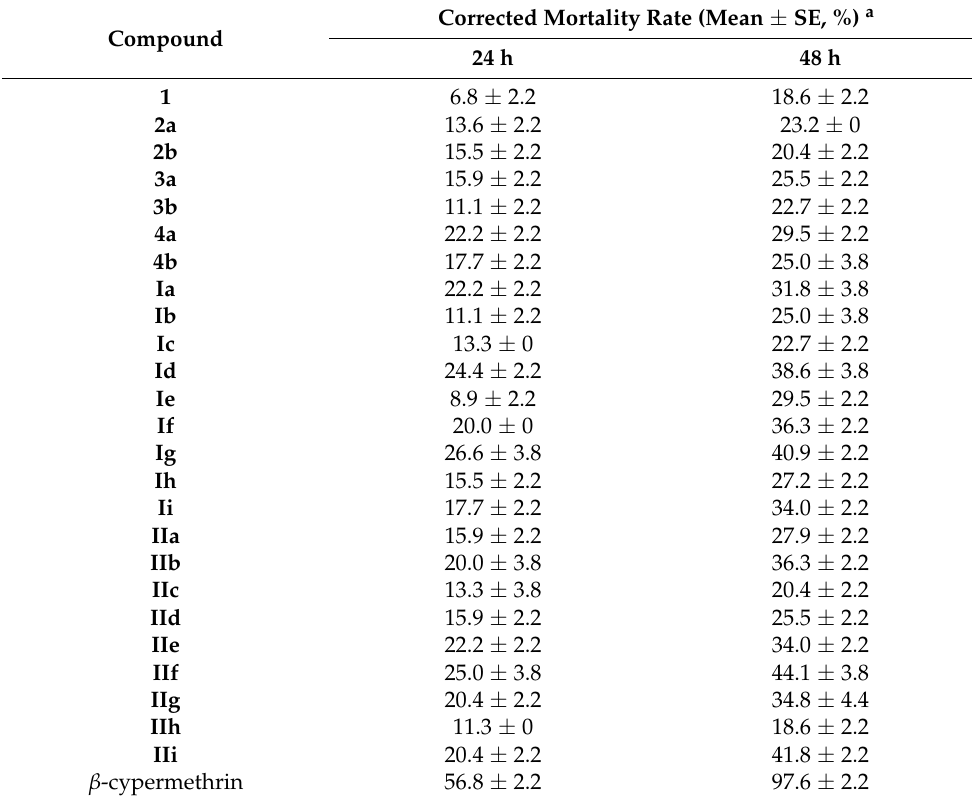
Table 2. The insecticidal activity of compounds I ( a – i )– II ( a – i ) against P. xyllostella at 1